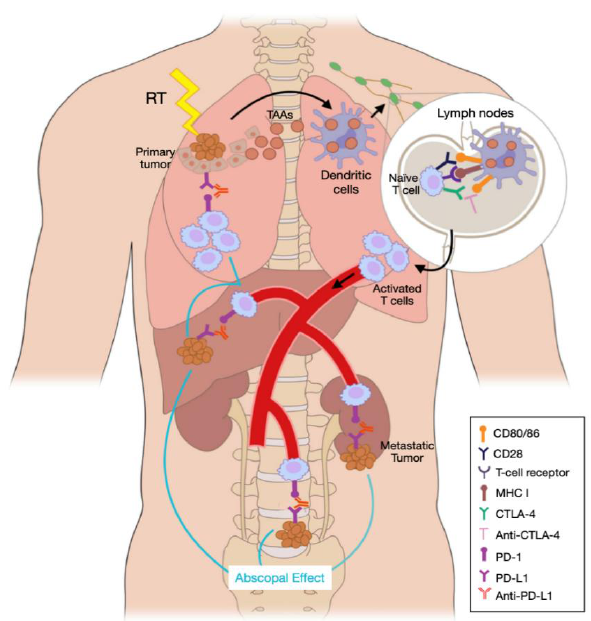
Figure 1. When delivered to the tumor, radiotherapy (RT) induces immunogenic cell death and the release of tumor-associated antigens (TAAs) nearby. Dendritic cells (DC) recognize these TAAs and carry them to the lymph nodes, where they present them to naïve CD8 + T cells through the major histocompatibility complex I (MHC I) and CD80 / 86 and CD28 receptors. At this point, anti-cytotoxic T lymphocyte-associated antigen (CTLA)-4 agents block the CTLA-4 receptor in naïve T cells, which ceases their inhibition. Activated cytotoxic T cells are then incorporated into the bloodstream and travel to distant metastases and back to the irradiated tumor to eliminate the disease. At this stage, anti-PD-1 / L1 therapy blocks the interaction between these two receptors, which allows for a stronger antitumor e ff ect driven by T